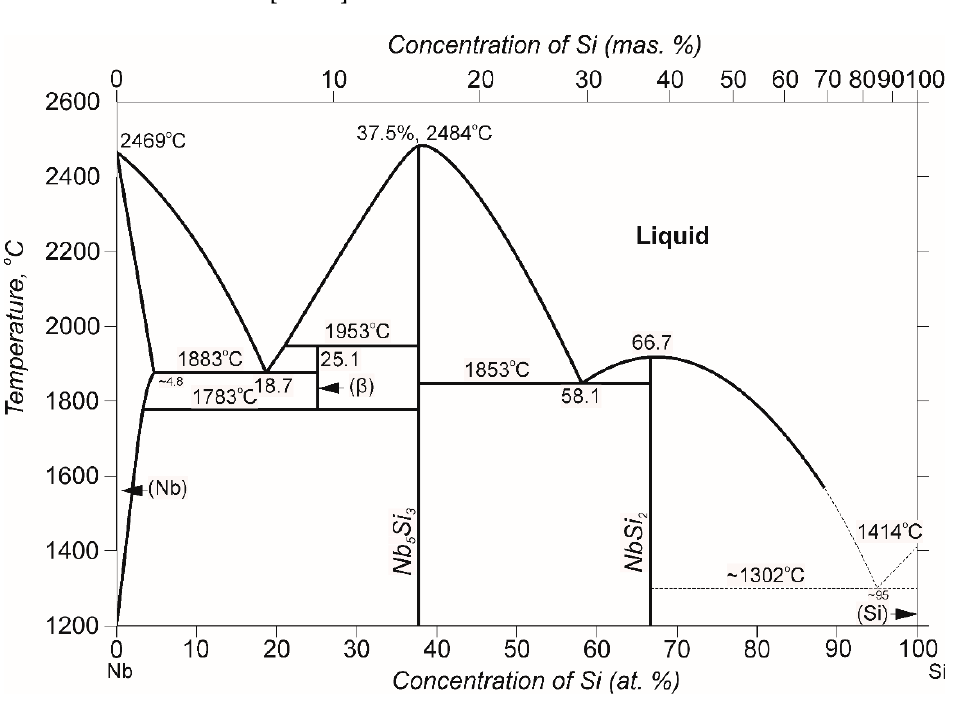
Figure 3. Schematic binary Nb ‐ Si phase diagram. Taken from Ref. [12] with permission from ASM. Copyright 1986, ASM.